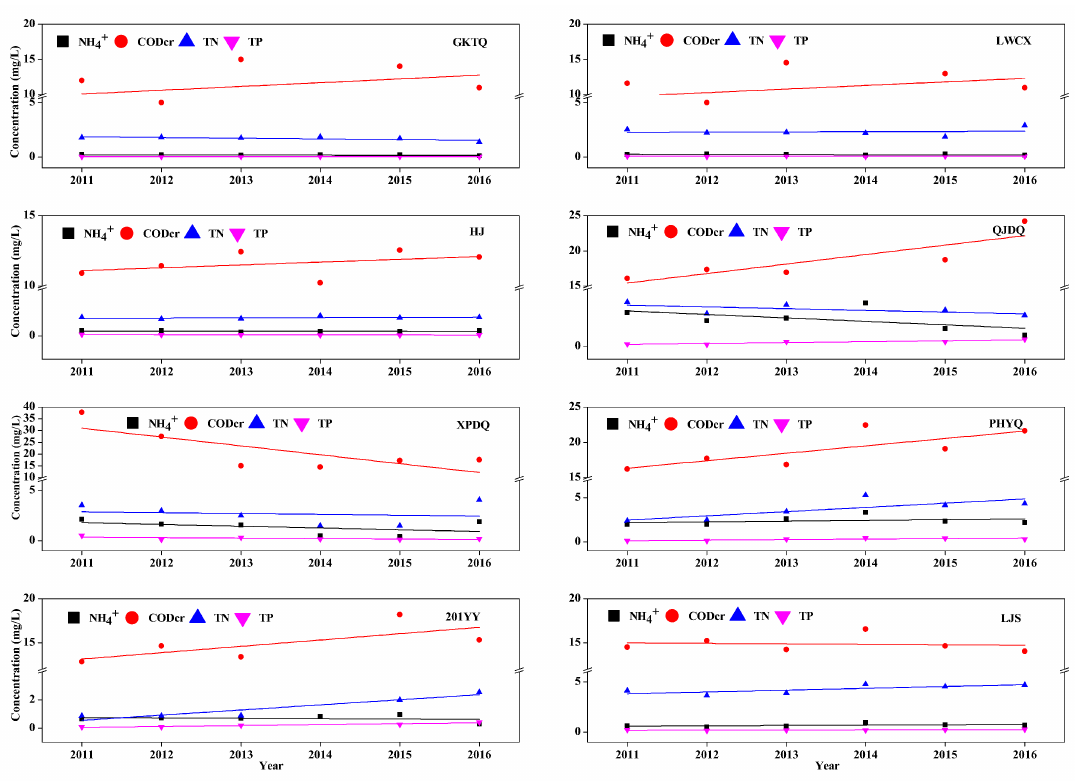
Figure 2. Temporal variations of NH 4+ , TN, TP and CODcr in the typical monitoring